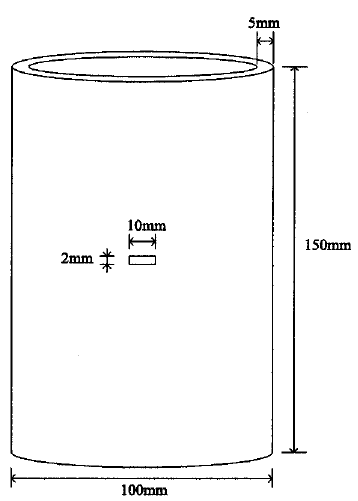
Figure 1. Dimensions of the aluminum pipe with a groove.